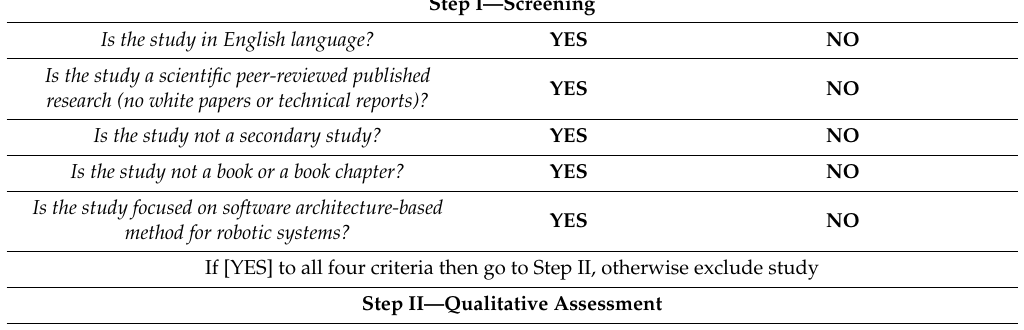
Table 3. Summary of the study selection process (screening and qualitative assessment). Step